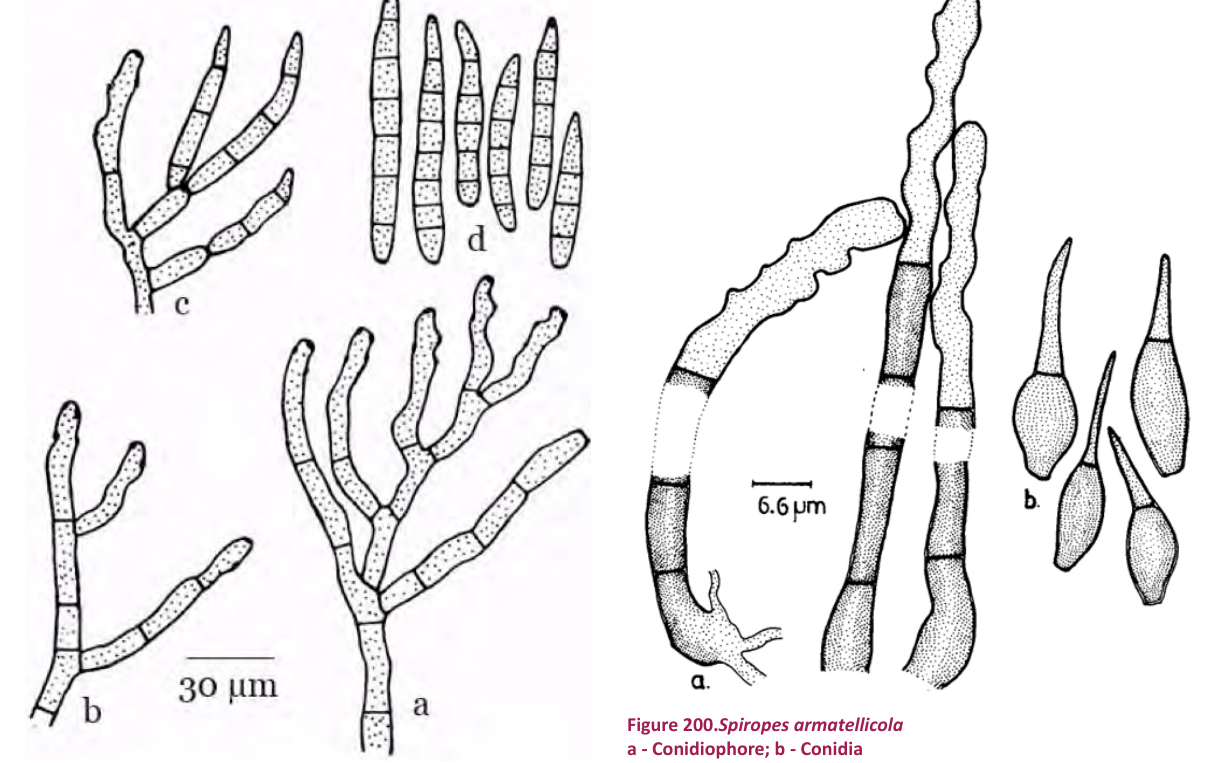
Figure 199. Passalora gmelinae-arboreae a - Profusely branched conidiophores; b - Conidiophore with conidiogenous cells; c - Conidia attached to conidiogenous cells; d - Conidia